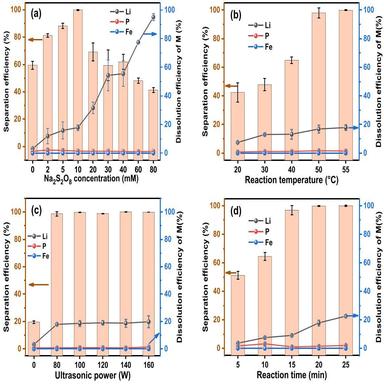
The effects of (a). Na2S2O8 concentration, (b). Reaction temperature, (c). Ultrasonic power and (d). Reaction time on the separation efficiency of CMs and dissolution efficiency of different metals.